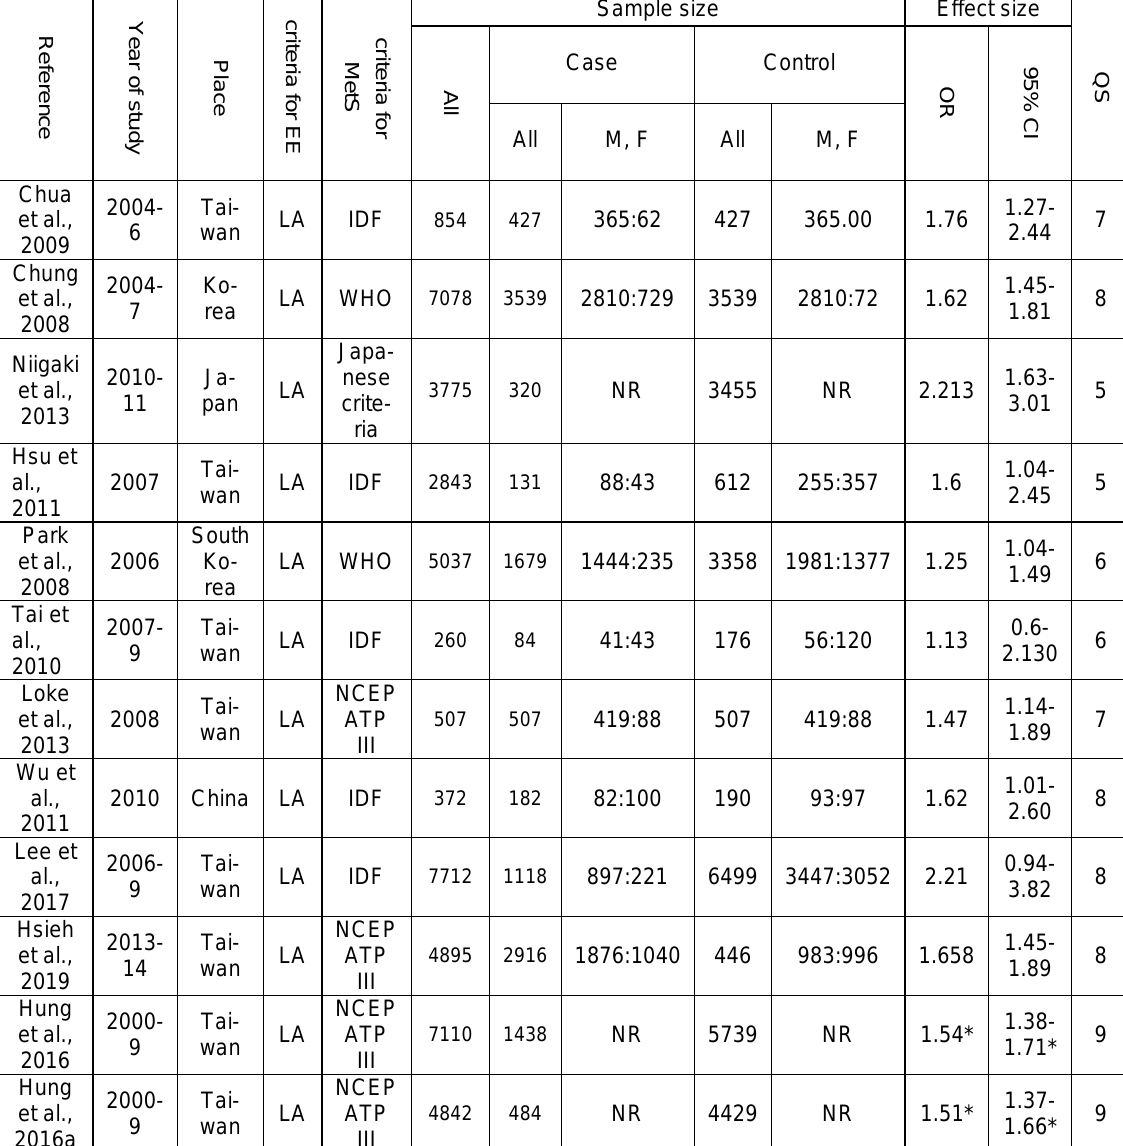
Table 1: Summary of characteristics in studies into a meta-analysis